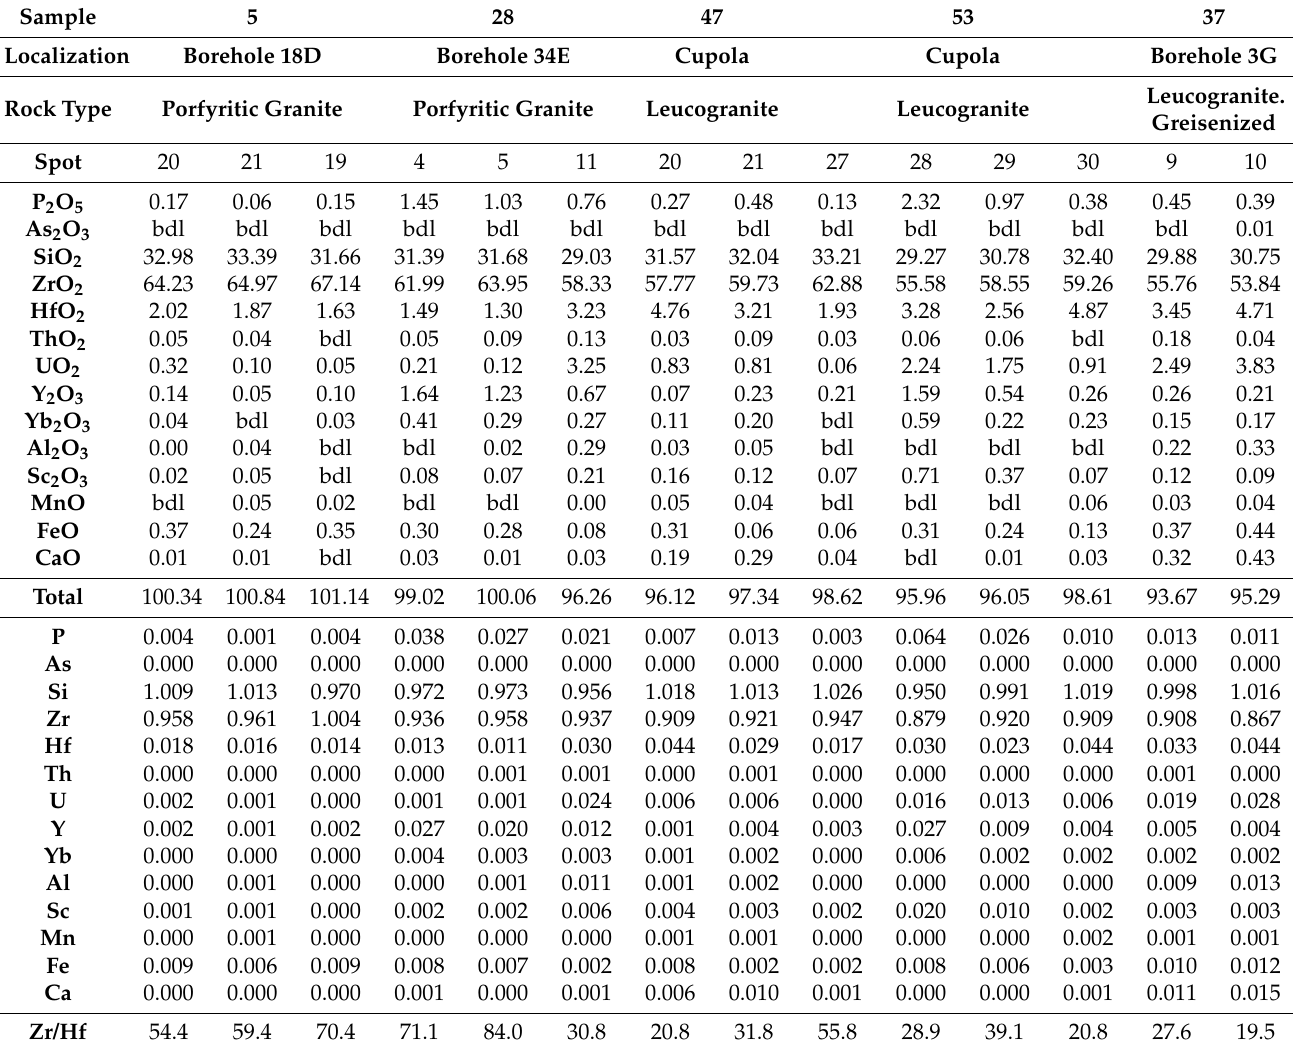
Table 7. Chemical composition (wt.%, EMPA) and empirical formulae of zircon, bdl = below detection